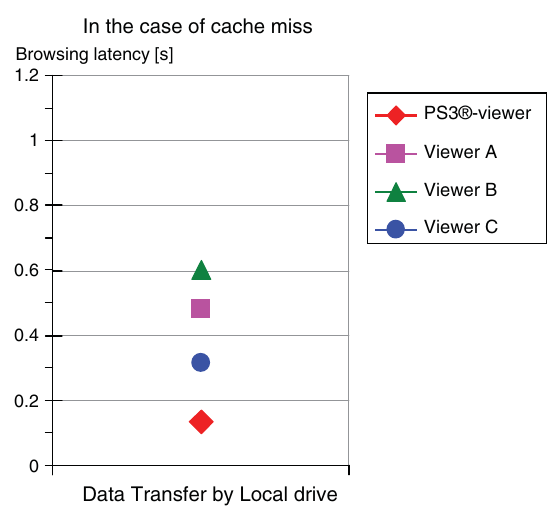
Fig. 9. Access Speed comparison between 3 PC based viewers and PS3 ® viewer: Local. Average latency when clicking on the four corners of a thumbnail